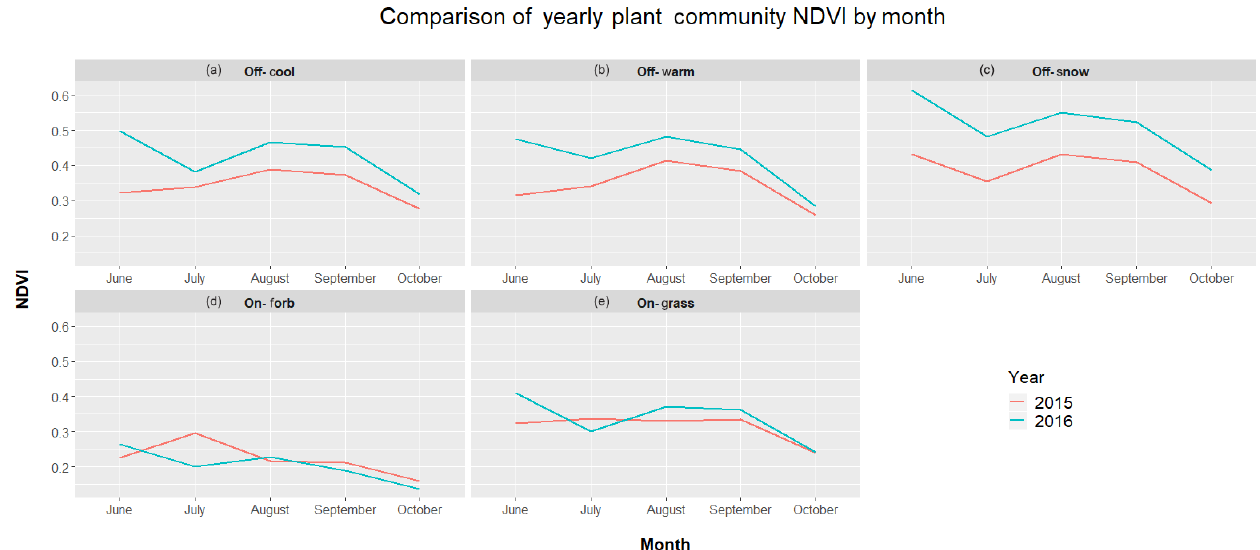
Figure 3. Comparison of mean monthly NDVI for training polygons in five plant communities at the study site in north central SD. Plant communities on prairie dog towns are grass-dominated (On-PDG) and forb-dominated (On-PDF); plant communities in off-town areas are